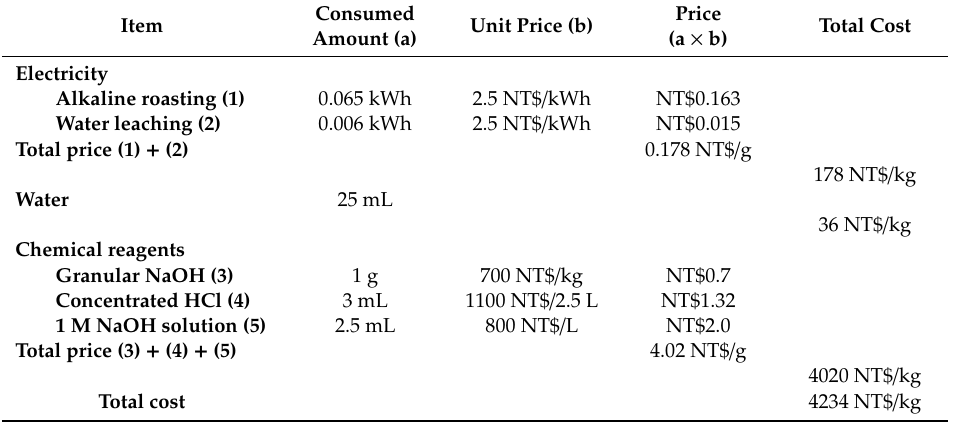
Table 2. Cost of the proposed recovery method for the treatment of 1 kg abrasive–glass polishing waste (calculated based on the optimal experimental conditions: abrasive–glass polishing waste: approximately 1 g; roasting temperature: 450 ◦ C; mass ratio of polishing waste to NaOH: 1:1;